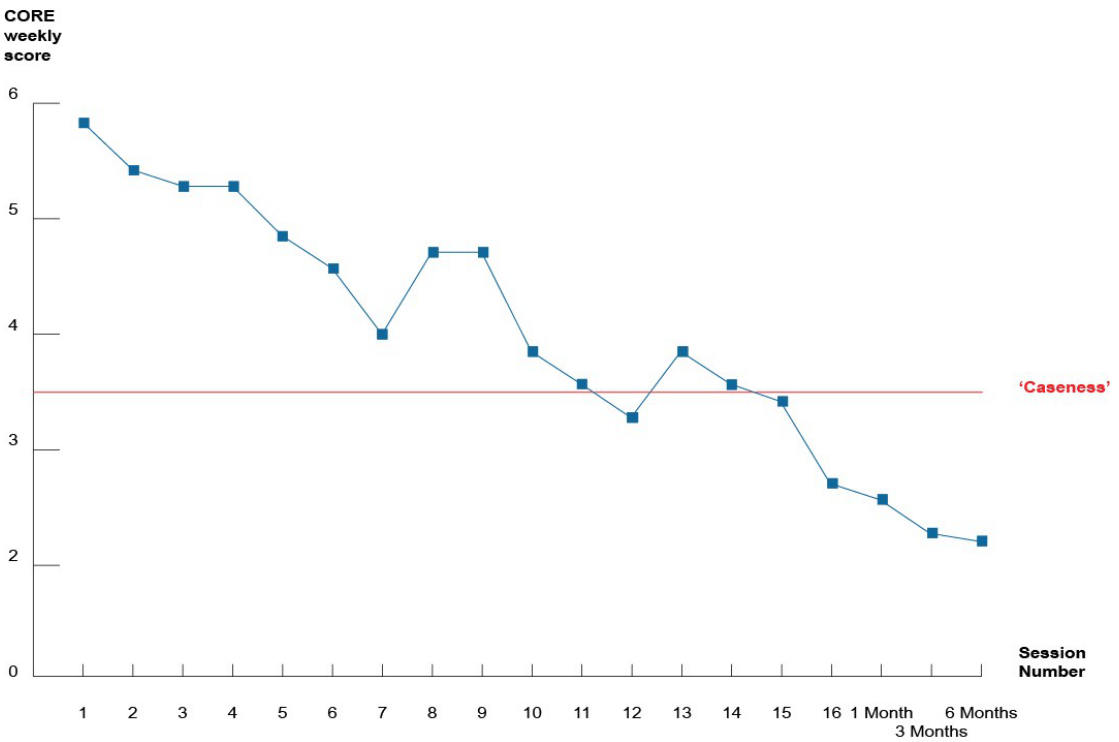
Figure 2. Weekly mean PQ